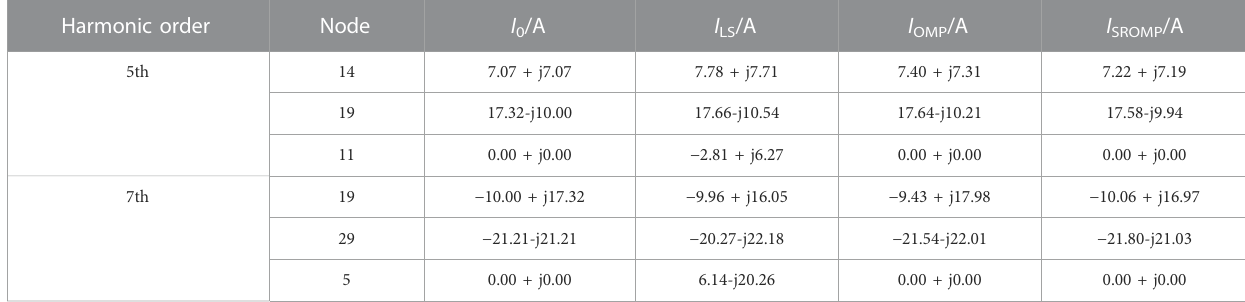
TABLE 3 Harmonic injection current estimation